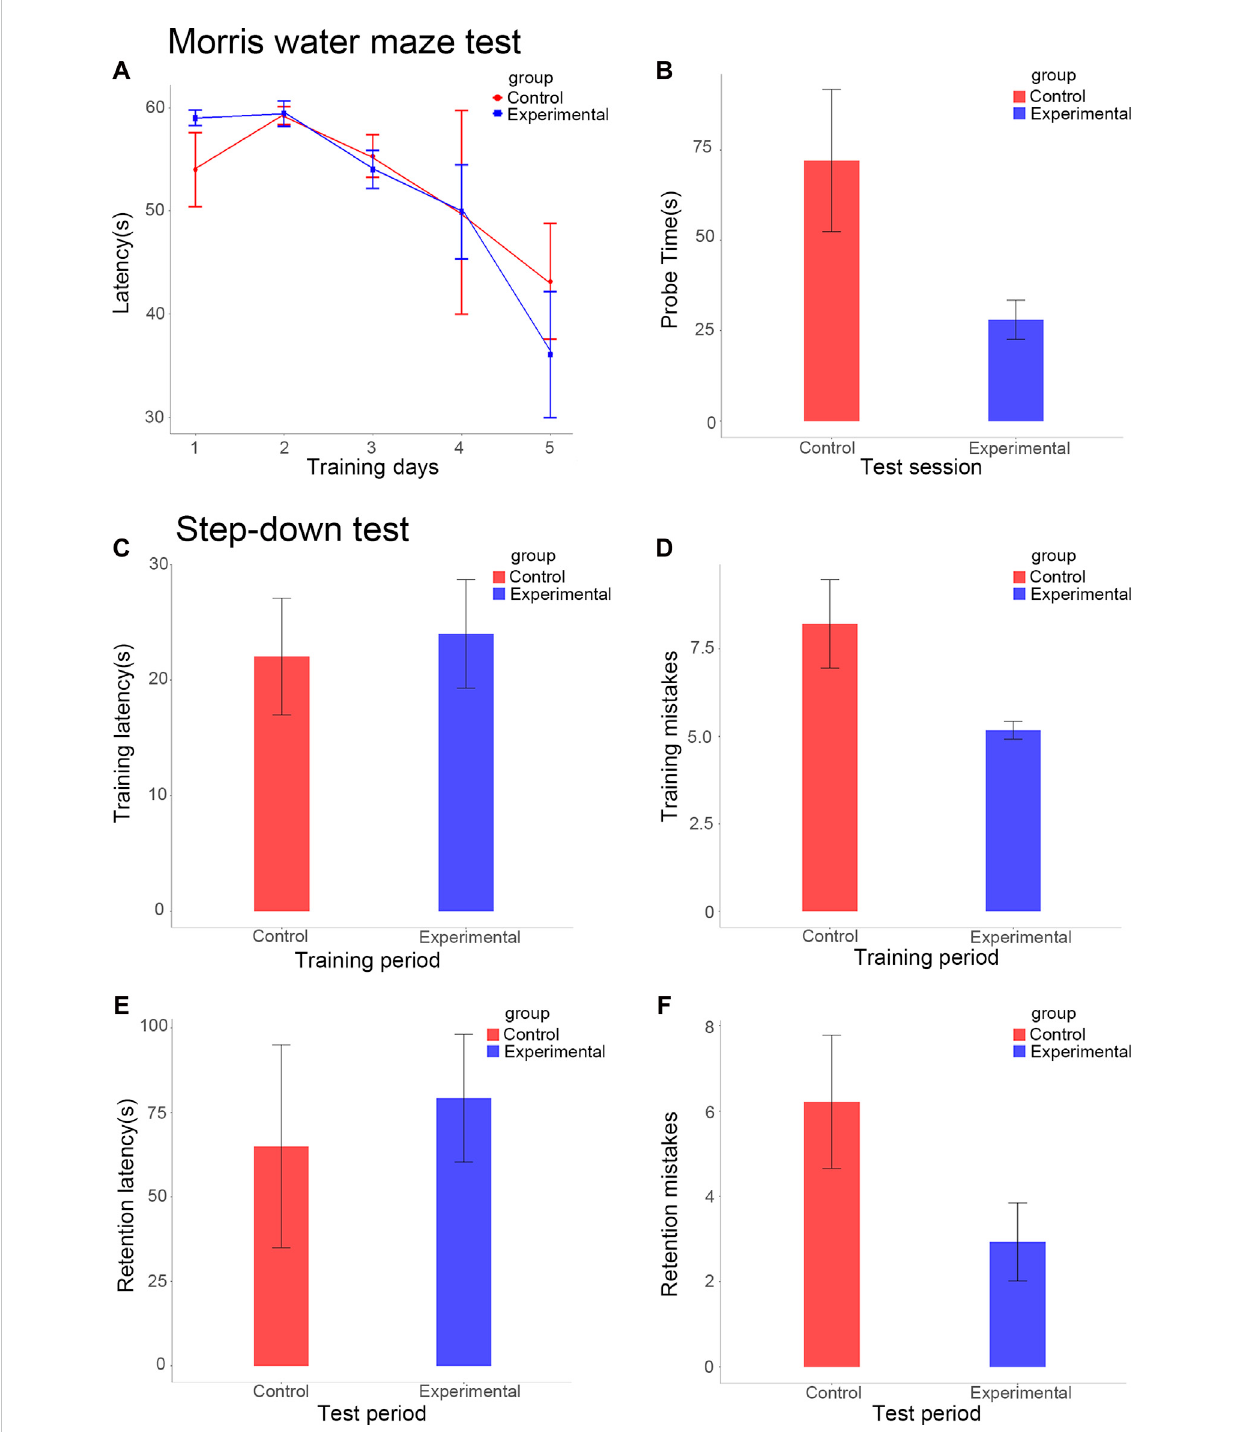
FIGURE 1 Escape latencies of the experimental and control groups over fi ve consecutive training days (A) . Escape latencies of the experimental and control groups in the test session (B) . Step-down latency of the experimental and control groups during training (C) and test sessions (E) . Error counts in the experimental and control groups during the training (D) and test sessions (F)